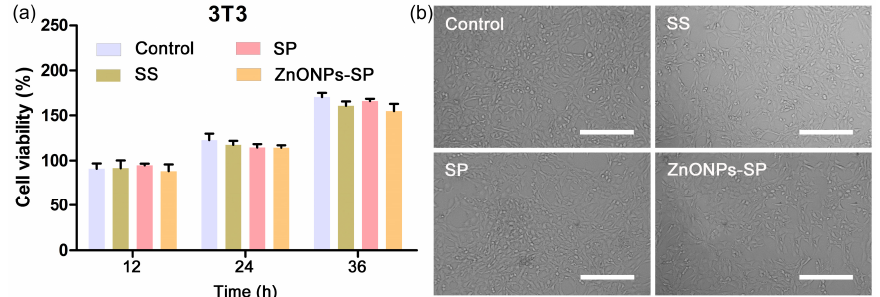
Figure 8. The cytocompatibility of ZnONPs-SP sponge. ( a ) CCK-8 analysis, ( b ) Cells morphology imaged on an optical microscope after 24 h. PBS was used as control. Scale bar, 200 µ